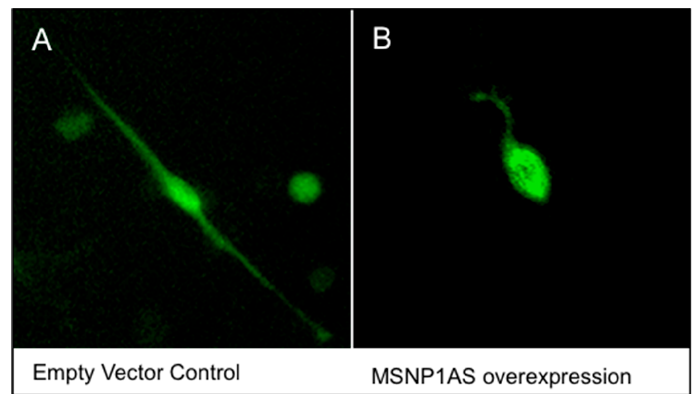
Figure 1. Representative ReNcell CX cells at 24 h post ‐ transfection. The human neural progenitor cells were transfected with ( A ) an empty vector control or ( B ) the MSNP1AS overexpression vector. For each experiment, the transfection of MSNP1AS over ‐ expression or control vector was repeated four times. Three randomly selected fields from each of the four replicates were imaged and all isolated GFP ‐ positive cells within the imaged fields were examined for neurite length and neurite number using Autoneuron software.